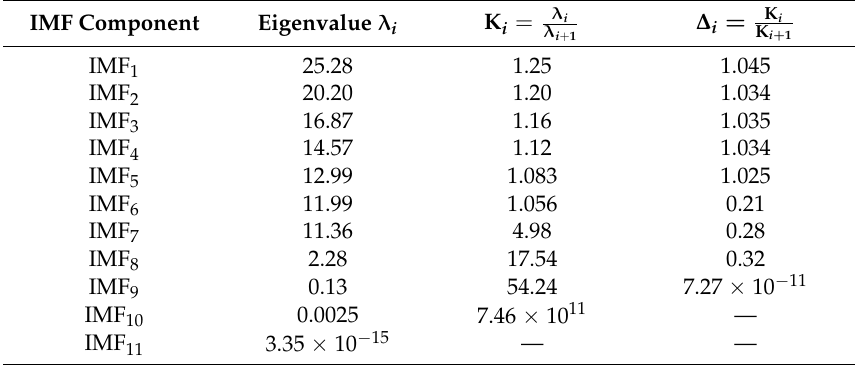
Table 3. IMF component, eigenvalue and ratio of wire rope break signal.